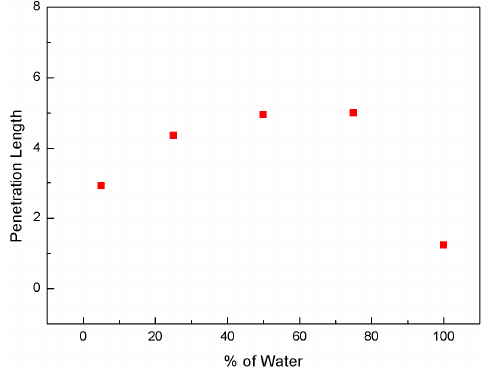
Figure 5. Change in penetration length with respect to water fraction at 65/40 bar.